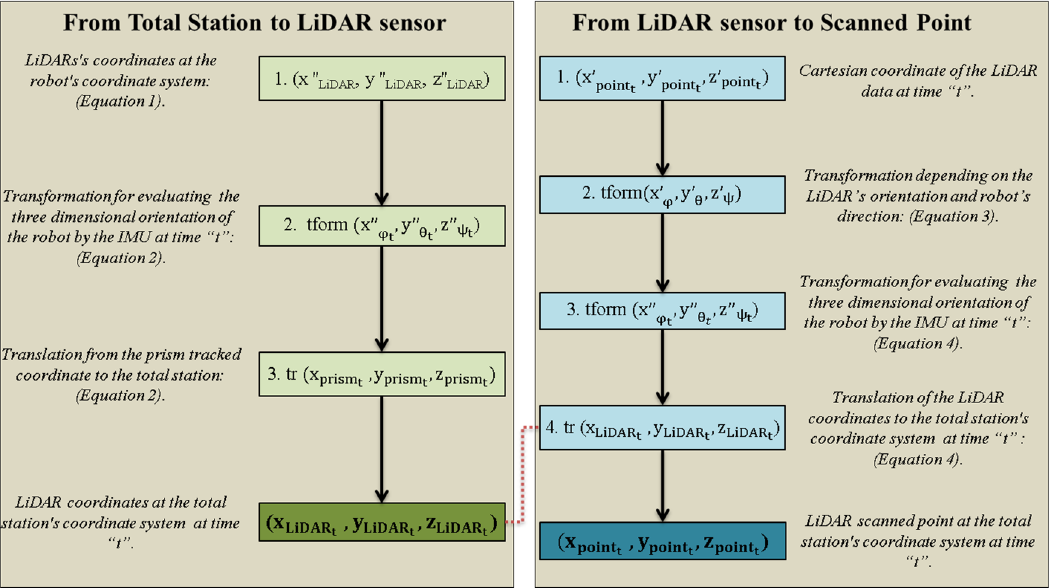
Figure 3. ( Left ) Transformation and translation process from total station to the LiDAR, and ( Right ) from the LiDAR to the scanned point. Double quoted, single quoted, and unquoted correspond to the robot’s, LiDAR’s, and total station’s coordinate system, respectively.